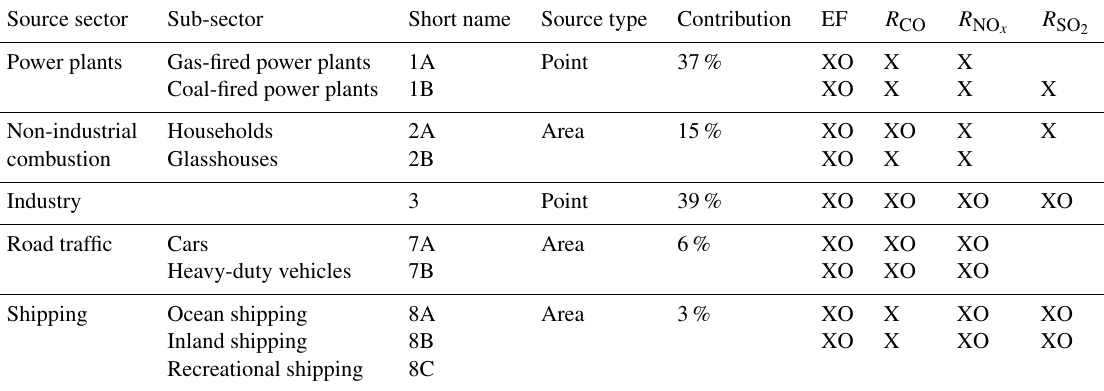
Table 1. Overview of source sectors and sub-sectors distinguished in the dynamic emission model, including their short name used in the figures, their source type, and their approximate contribution to the total CO 2 emission in Rotterdam (Netherlands PRTR, 2014). Crosses (X) indicate which emission factors (EFs) and tracer ratios of CO, NO x , or SO 2 ( R CO , R NO indicate whether they are also part of the short state vector (see Sect.